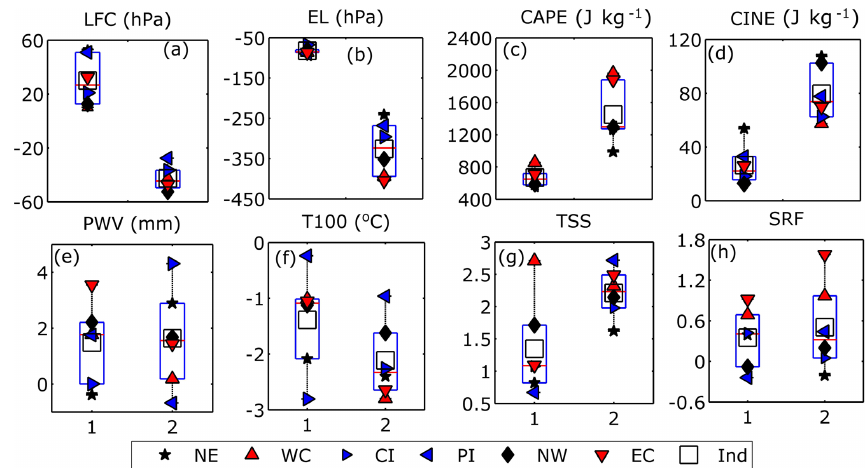
Figure 8. Comparison of average values for two time periods indicating the trend of various instability parameter over the six subdivisions of India in two half periods of 18 years each (the numbers 1 and 2 represent the first and second period, C1 and C2, during 1980–1997 and 1999–2016, respectively) during 1999–2016. Legends are the same as in Fig. 4.